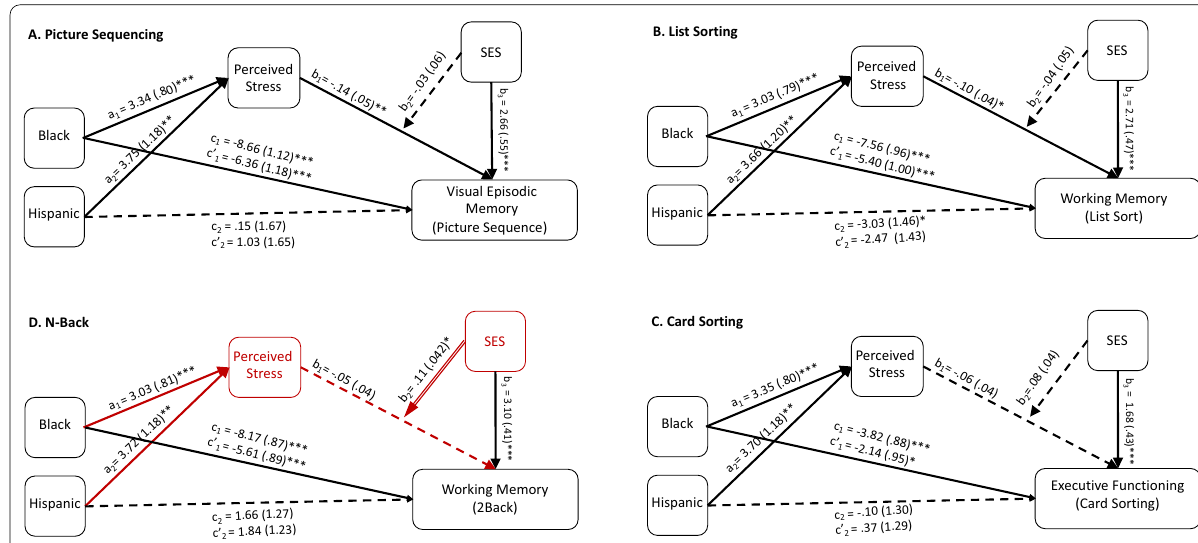
Fig. 5 Moderated mediation analyses for picture sequencing ( A ), list sorting ( B ), card sorting ( C ), and the N‑back ( D ). Socioeconomic status (SES) moderated the effect of perceived stress on ethnoracial disparities in cognition only for card sorting and the N‑back task. Unstandardized parameter estimates and standard errors are shown for each pathway. Asterisks denote significant pathways for one ethnoracial minority with a single line and for both ethnoracial minorities with a double line: * p < .05, ** p < .01, *** p < .001. Dashed lines represent non‑significant pathways. Red lines = = = and text represent significant mediating